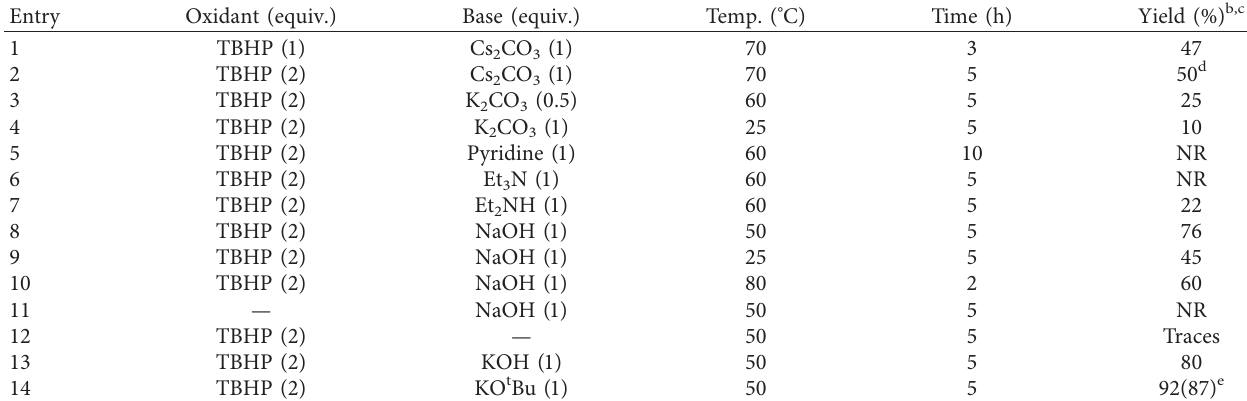
Table 2: Optimization of hydroxylation parameters a .